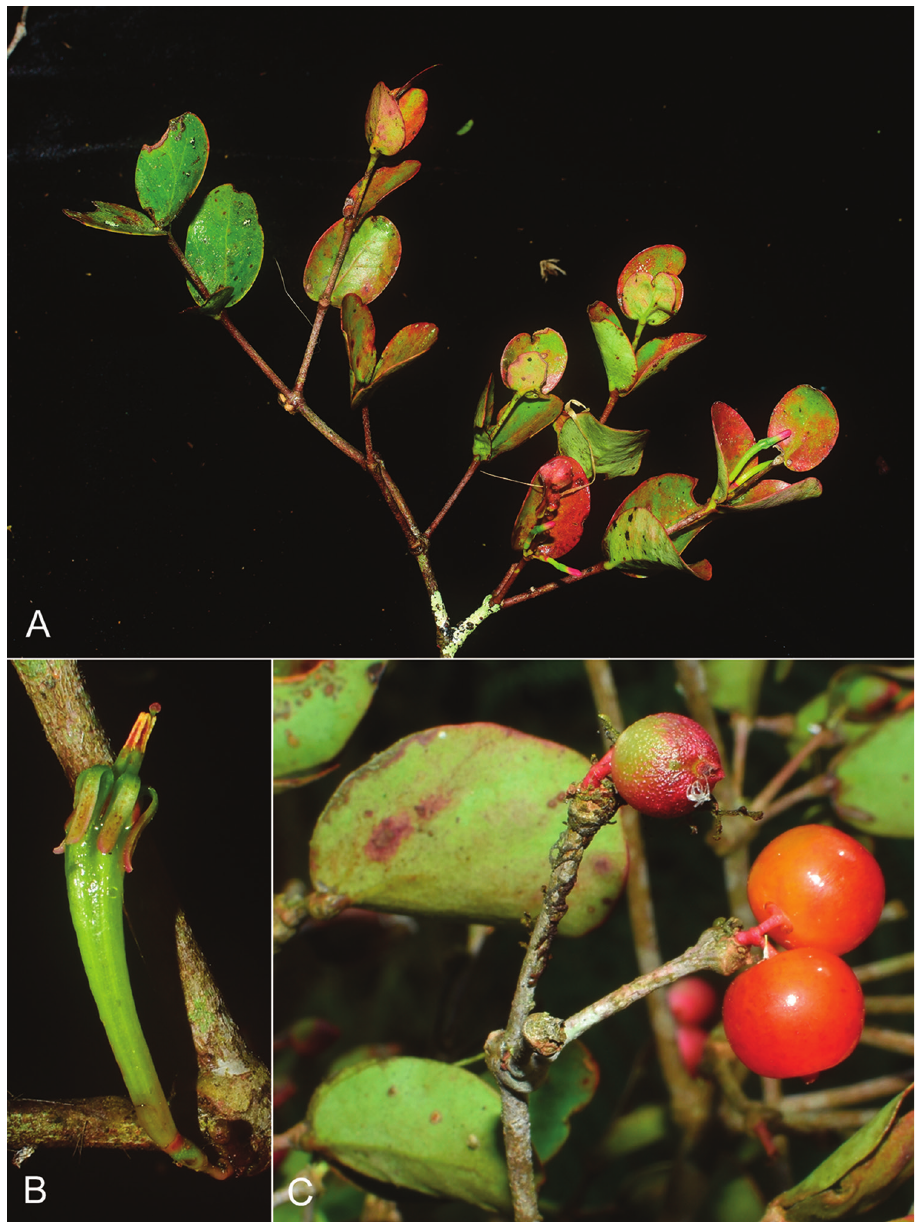
Figure 2. Macrosolen bidoupensis Tagane & V.S.Dang. A Branch with flower buds B Flower C Fruits. Photos by Tagane et al. V4083